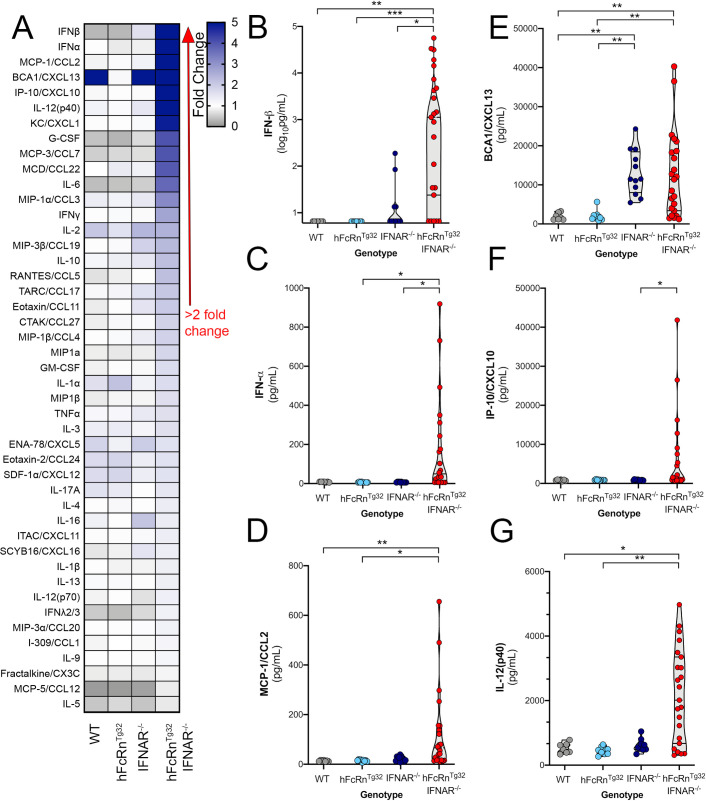
hFcRnTg32-IFNAR-/- animals induce a robust immune response to E11 infection.C57/BL6 (WT, gray), hFcRnTg32 (light blue), IFNAR-/- (dark blue), and hFcRnTg32-IFNAR-/- (red) animals were IP inoculated with 104 PFU of E11 and sacrificed 72 hours post inoculation. Luminex-based multianalyte profiling of 45 cytokines was then performed from whole blood. (A) Heatmap demonstrating the induction (shown as fold-change from uninfected control) in E11-infected mice of the indicated genotype. Blue denotes significantly increased cytokines in comparison to uninfected. Grey or white denote little to no changes (scale at top right). The red arrow demonstrates cytokines with greater than 2-fold upregulation observed in the average of separate experiments. Luminex assays were performed in duplicate. (B-G) IFN-β (B), IFN-α (C), MCL-1/CCL2 (D), BCA1/CXCL13 (E), IP-10/CXCL10, and IL12(p40) cytokine levels in the blood of E11 infected C57Bl/6 (WT, gray), hFcRnTg32 (light blue), IFNAR-/- (dark blue), and hFcRnTg32-IFNAR-/- (red) animals. Symbols represent individual mice. Significance was determined with a Kruskal-Wallis test with a Dunn’s test for multiple comparisons (*p<0.05, **p<0.005, ***p<0.0005).